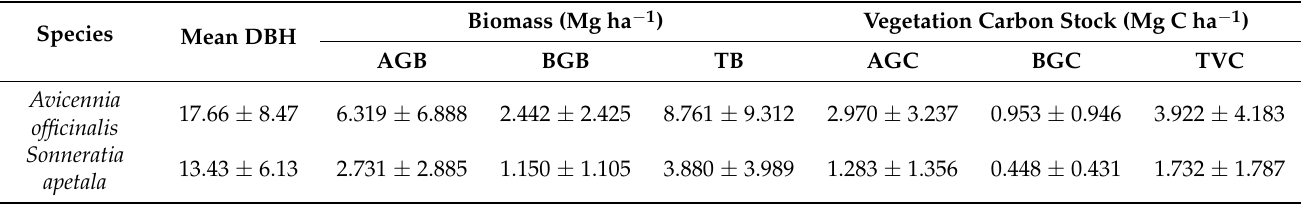
Table 4. Mean diameter breast height, biomass, and carbon stock of recorded mangrove species in mangrove stands of LetKhutKon Village (mean ±